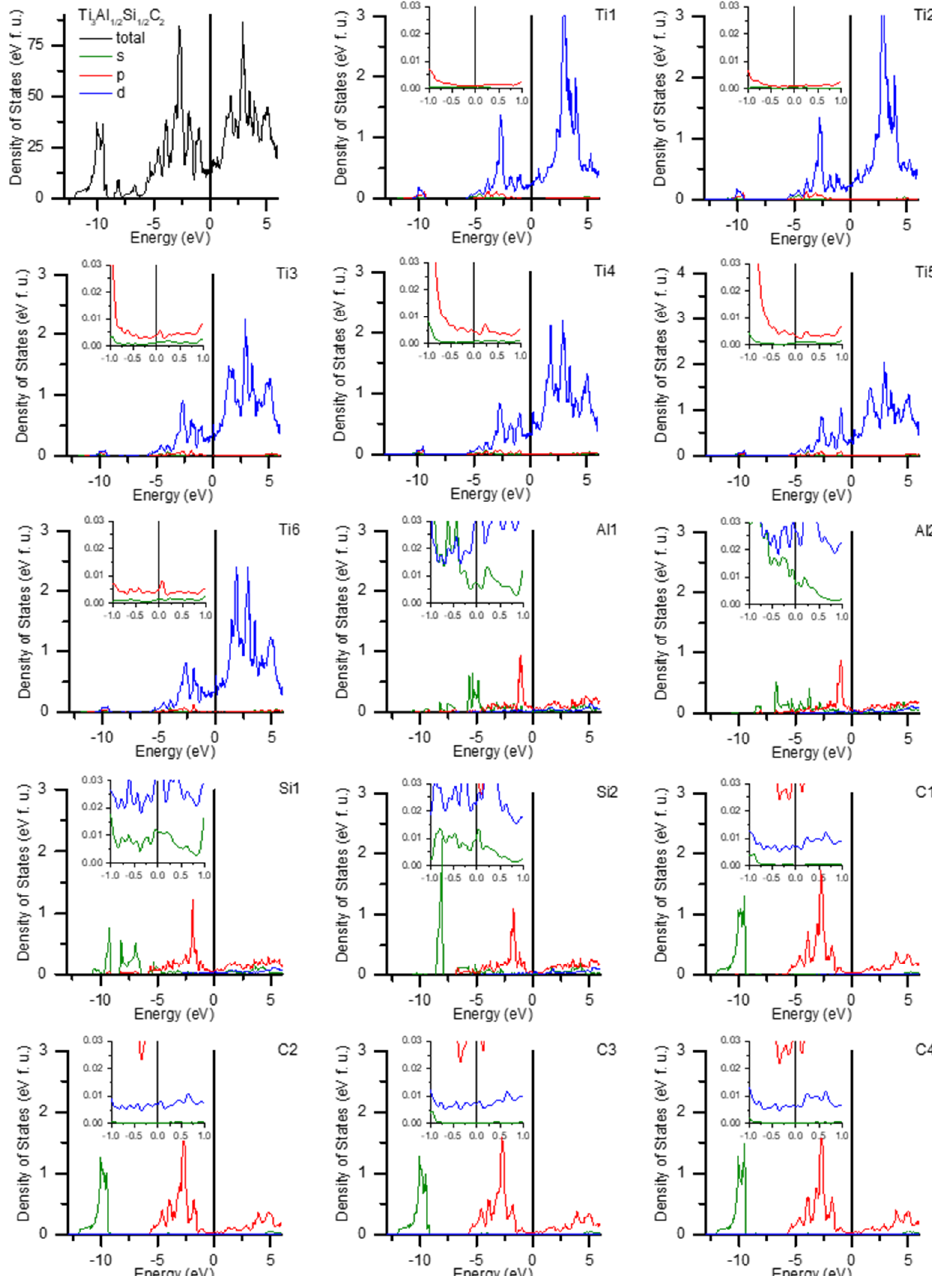
Figure 12. Calculated density of states of the Ti 3 Al 1/2 Si 1/2 C 2 compound. Densities of states for s (green), p (red), and d (blue) sub-bands and the total density of states (black) are presented.